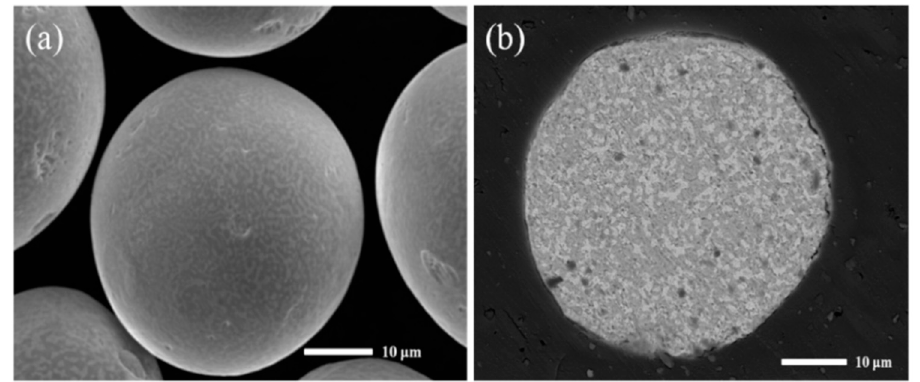
Figure 2. Microstructure of eutectic Sn-Pb alloy powder. ( a ) The surface morphology, and ( b ) cross-sectional microstructure.